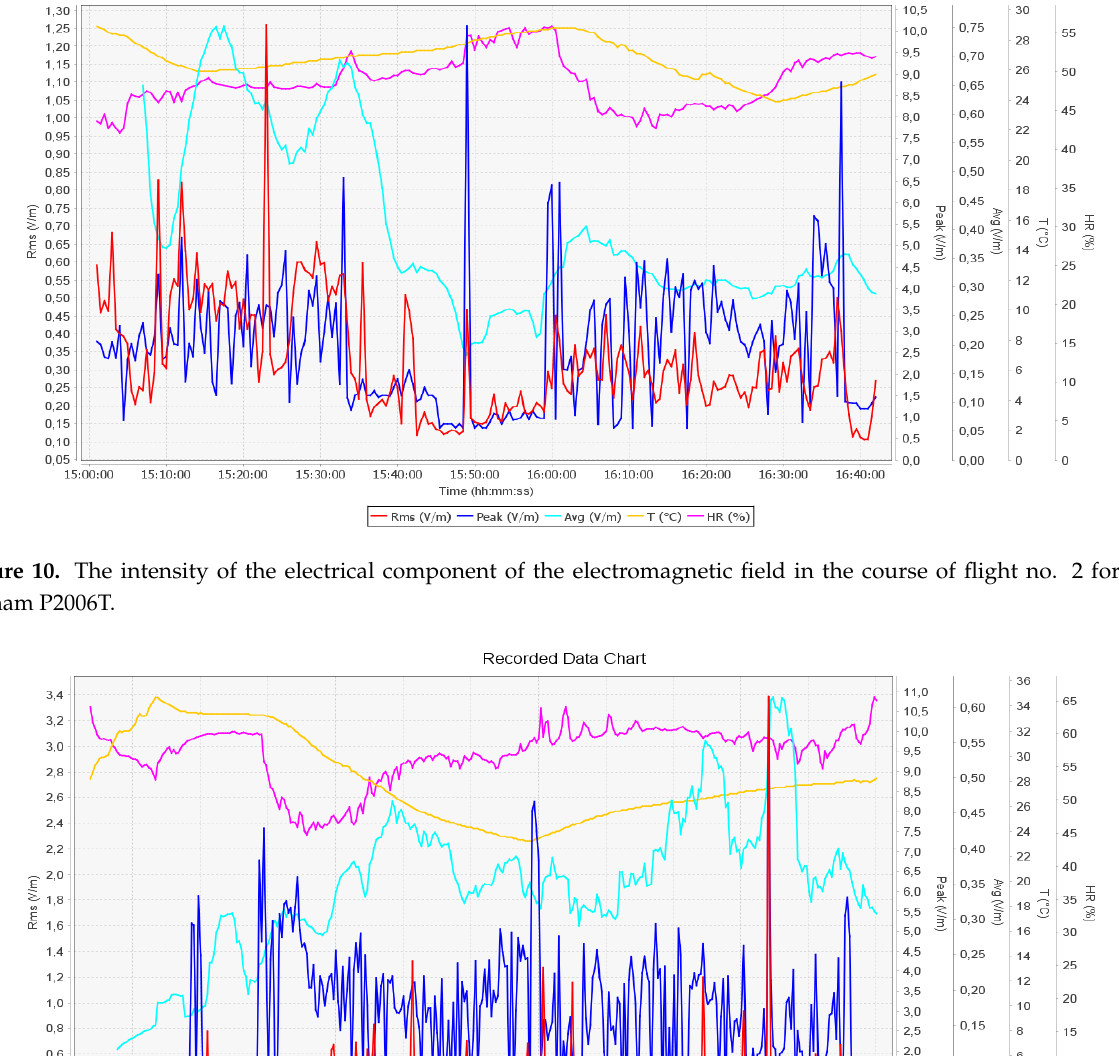
Figure 11. The intensity of the electrical component of the electromagnetic field in the course of flight no. 3 for the Tecnam P2006T.